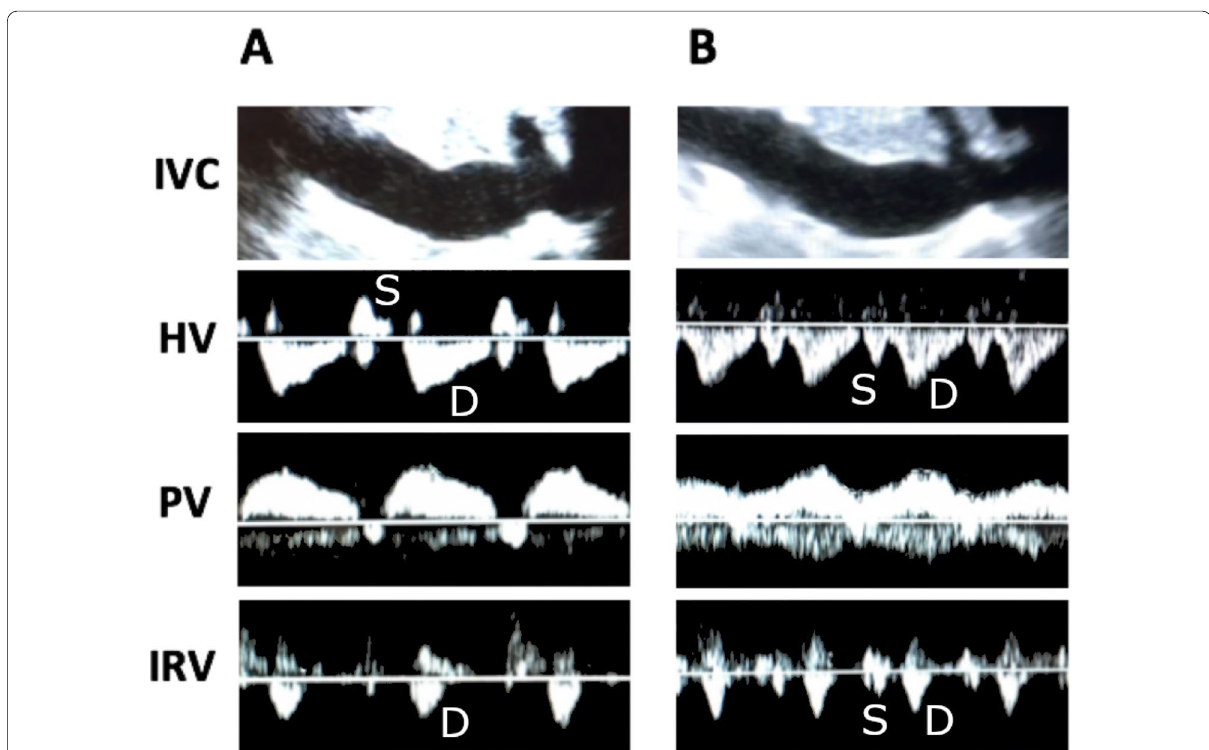
Fig. 5 Case 4: a initial congestive Doppler profiles. b Doppler profiles after hemodialysis with ultrafiltration of 2.5